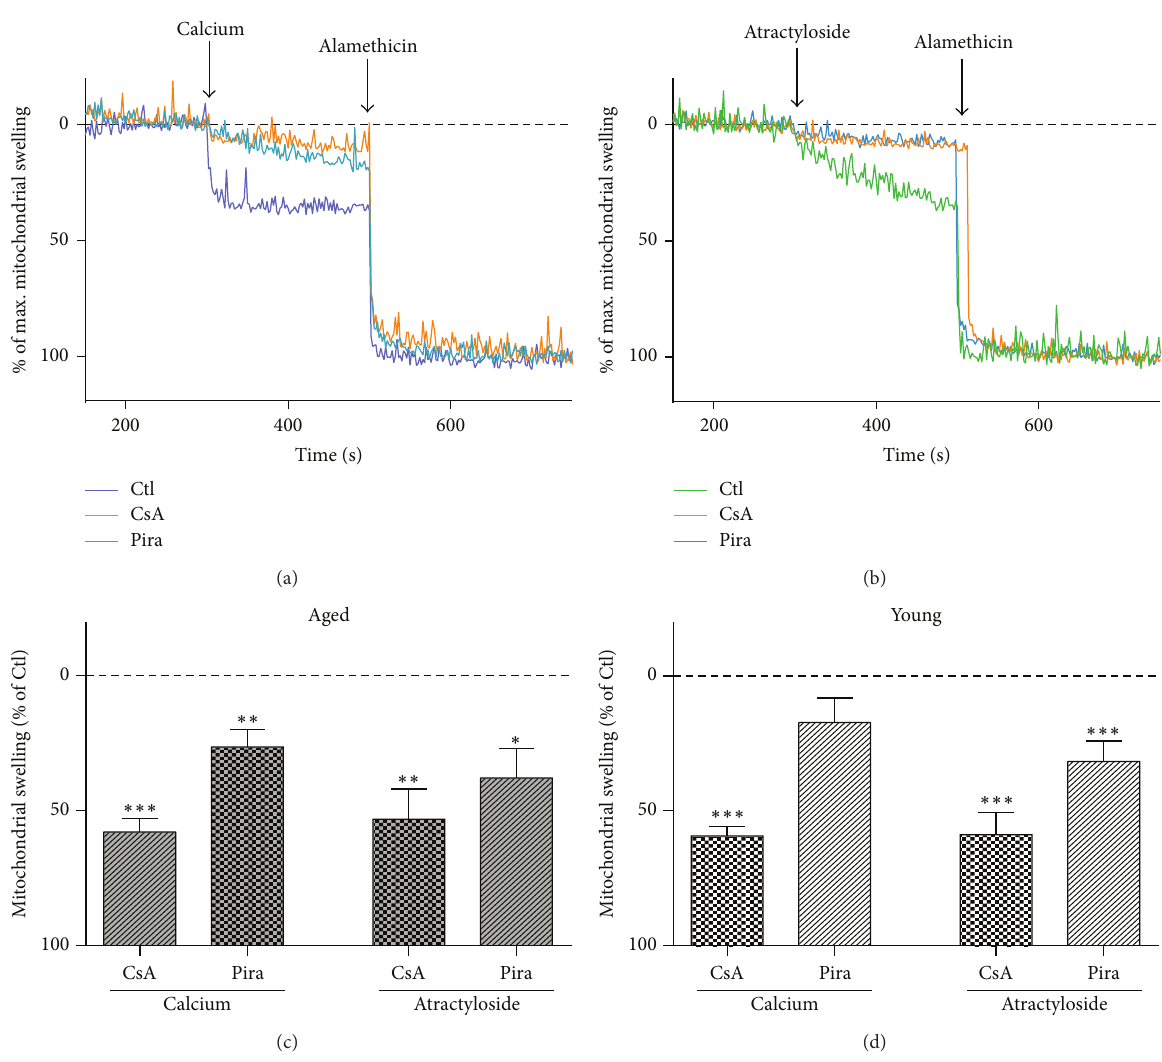
Figure 7: The metabolic enhancer piracetam reduces mPTP opening in aged mice. Mitochondrial permeability transition pore (mPTP) opening was induced by ((a), (c), and (d)) 1 𝜇 Mol/mg protein calcium or ((b), (c), and (d)) 400 𝜇 M atractyloside, maximal swelling was induced by alamethicin, and changes in absorbance by 540 nm were examined. Mitochondrial swelling after 5min preincubation with piracetam (Pira, 1mM) was analyzed using isolated mitochondria from (c) aged (18 months) and (d) young (12 weeks) NMRI mice. Cyclosporine A (CsA, 1 𝜇 M) was used as a positive control for the inhibition of mPTP opening. Data are expressed as mean ± SEM; Student’s paired 𝑡 -test ( ∗ 𝑝 < 0.05 , ∗∗ 𝑝 < 0.01 , and ∗∗∗ 𝑝 < 0.001 compared to mitochondria without CsA or Pira pretreatment); 𝑛 =